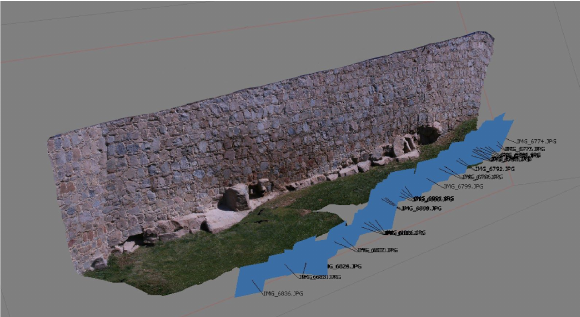
Figure 5. View of the textured model of one sectors of the ​ interior of the walls and images orientation.